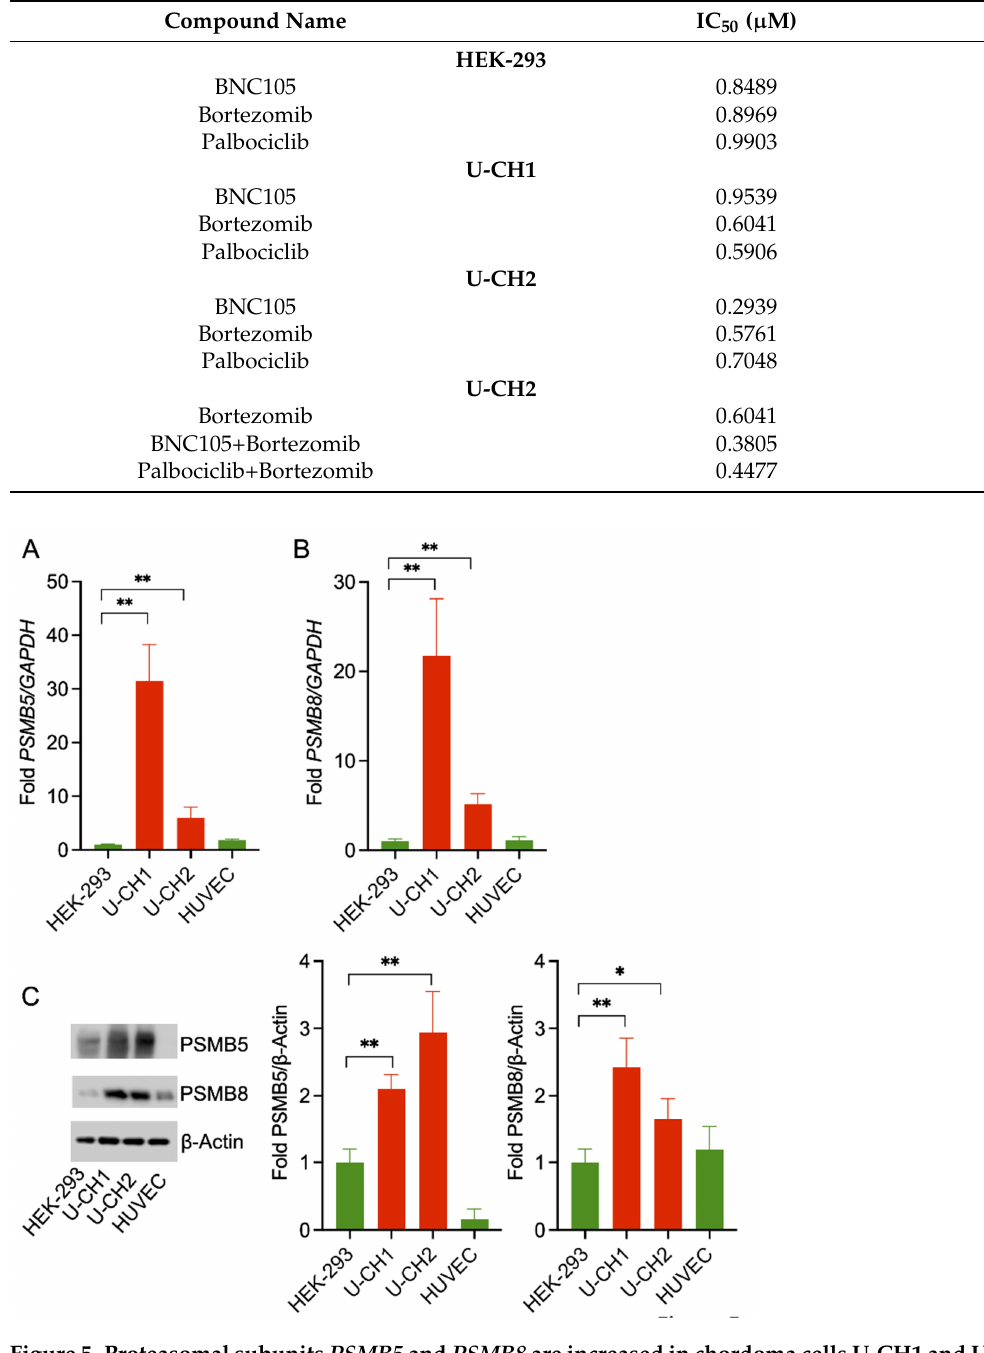
Table 4. List of IC 50 values for Bortezomib and anti-cancer drugs in HEK-293 and chordoma cells, individually or in combination.